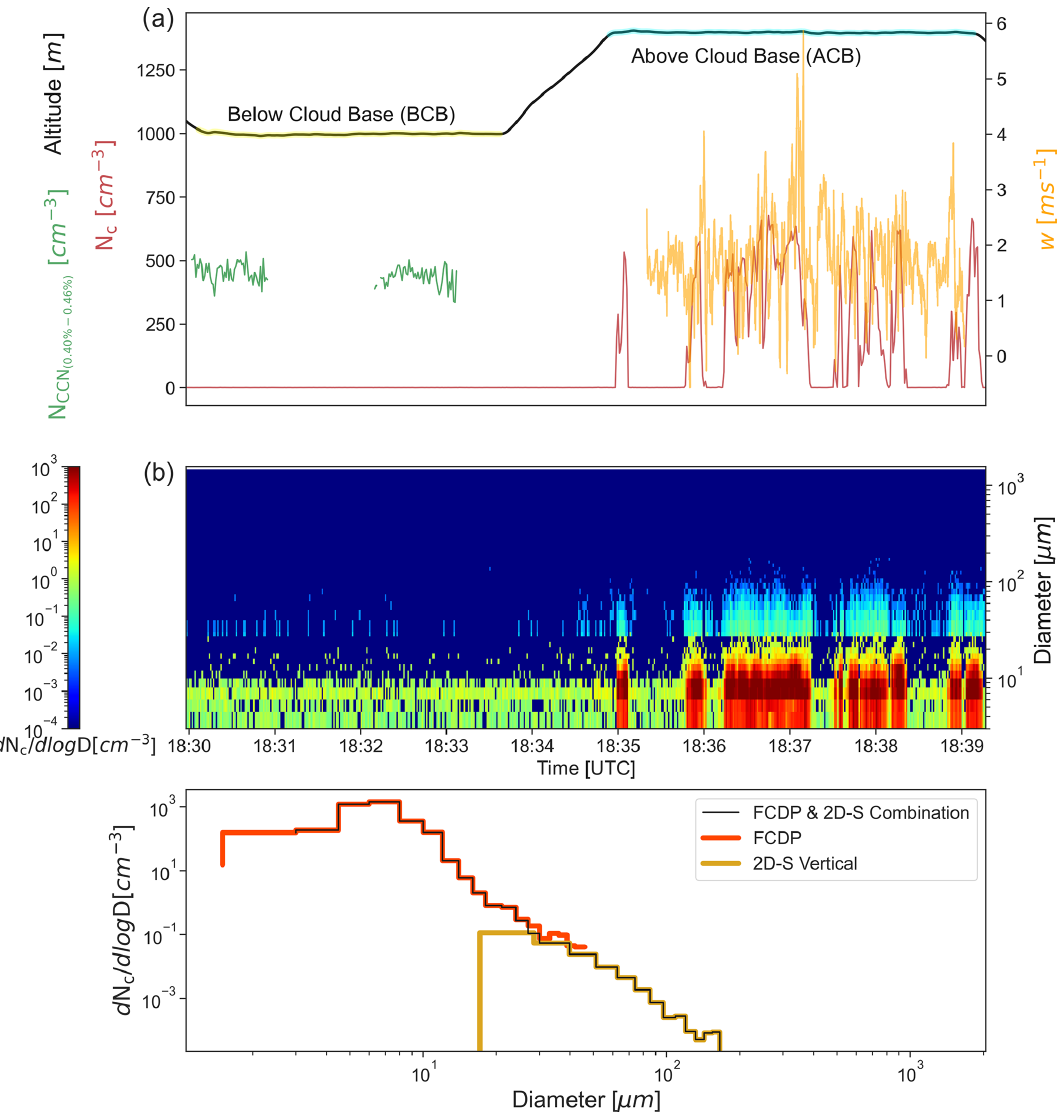
Figure 3. (a) Aerosol and cloud properties measured in an ensemble pair of BCB and ACB legs from RF02 on 15 February 2020. The Falcon altitude is given by the black line, and the yellow and blue shading indicates the BCB and the ACB legs. N C (red), N CCN (green) 0 . 43% and w (orange) are shown as lines. The aerosol loading N CCN , representative of the pair’s environment, is 440( ± 20)cm − 3 , calculated 0 . 43% from the measurements’ mean within the BCB leg between 0.40%–0.46% supersaturation of the CCN-100 scans nearest to the cloud measurement. The pair’s mean values with standard deviation for w and N C are 1 . 85( ± 0.82)ms − 1 and 385( ± 171)cm − 3 , respectively. (b) Histogram showing the color-coded log-normalized number concentrations per bin on a 1s basis of the 2D-S–FCDP combination with the diameter given in the ordinate and the derived mean particle size distribution of in-cloud seconds during the ACB leg